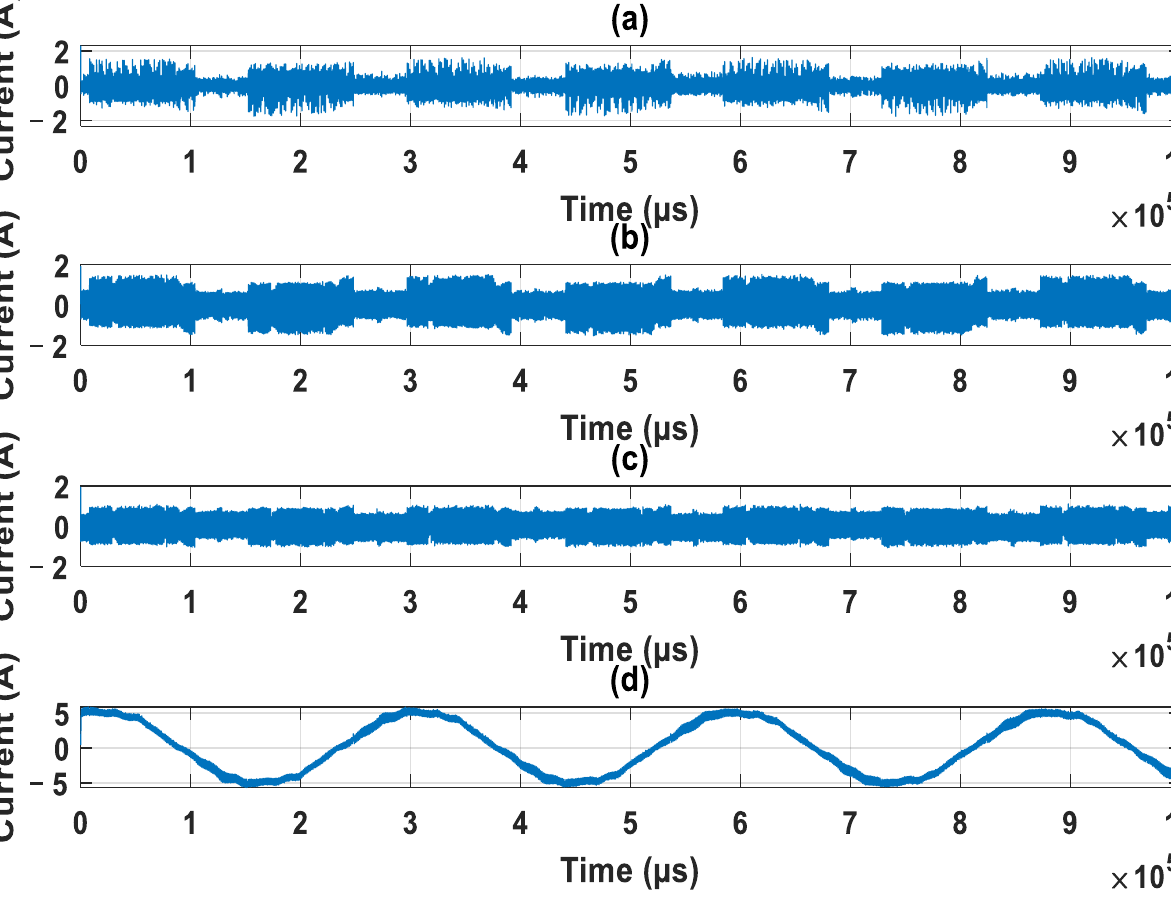
Figure 8. Decomposition of the signal. ( a ) Signal above 2.5 MHz, ( b ) Signal between 1.2 MHz and 2.5 MHz, ( c ) Signal between 600 kHz and 1.2 MHz, ( d ) Signal below 600 kHz.